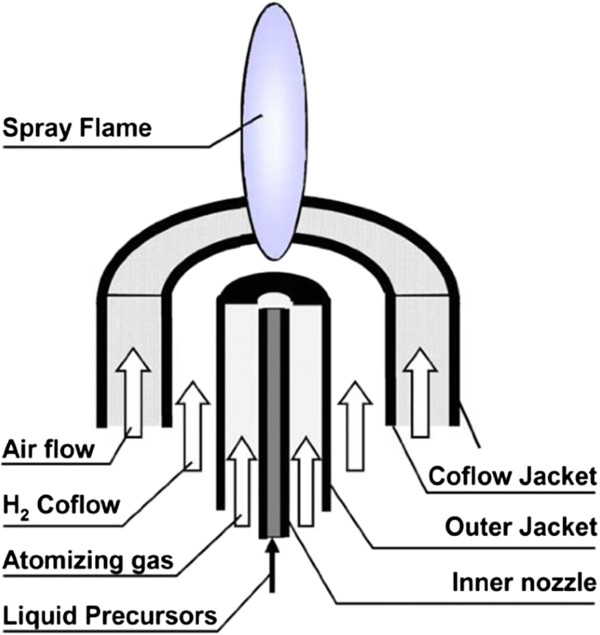
Flame spray pyrolysis burner schematic used for synthesizing Eu:Gd2O3 nanoparticles.